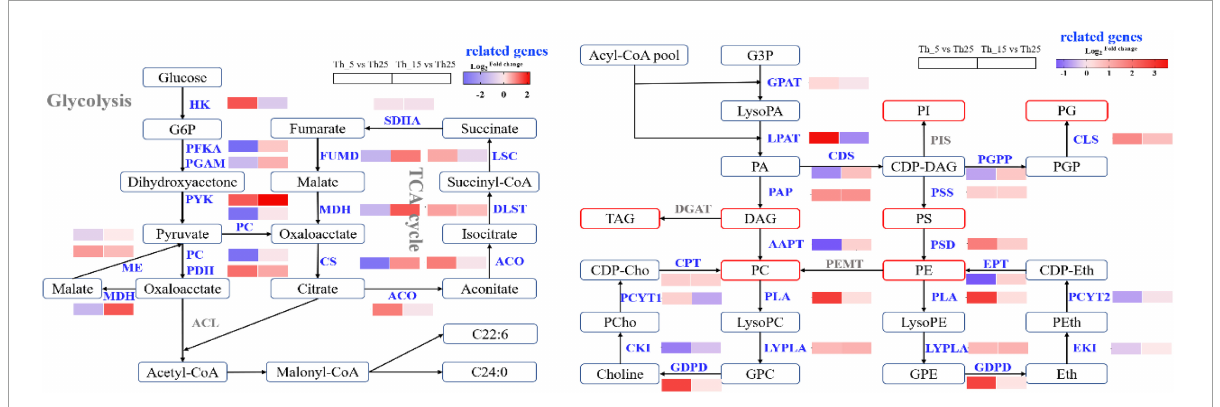
FIGURE4 Changes in transcript abundance of genes involved in glycolysis, TCA cycle, and glycerophospholipid biosynthesis under 5 and 15 ◦ C treatment in Aurantiochytrium sp. SZU445. GPAT, lycerol-3-phosphate acyltransferase; LPAT, lysophospholipid acyltransferase; PAP, phosphatidic acid phosphatase; AAPT, aminoalcoholphosphotransferase; PEMT, phosphatidylethanolamine/phosphatidyl-N-methylethanolamine N-methyltransferase; DGAT, diacylglycerol O-acyltransferase; PSS, phosphatidylserine synthase; PSD, phosphatidylserine decarboxylase; PGP, phosphatidylglycerophospate; CLS, cardiolipin synthase; PLA, phospholipase A; LYPLA, lysophospholipase; GDPD, glycerophosphoryl diester phosphodiesterase; EKI, ethanolamine kinase; CKI, choline kinase; HK, hexokinase; PFKA, 6-phosphofructokinase; PGAM, phosphoglycerate mutase; SDHA, succinate dehydrogenase; FUMD, fumarate hydratase; MDH, malate dehydrogenase; CS, citrate synthase; ACO, aconitate hydratase; DLST, dihydrolipoamide succinyltransferase; LSC, succinyl-CoA synthetase. The columns in the figure represent the fold changes of gene expression in Th_5 vs. Th_25 and Th_15 vs.